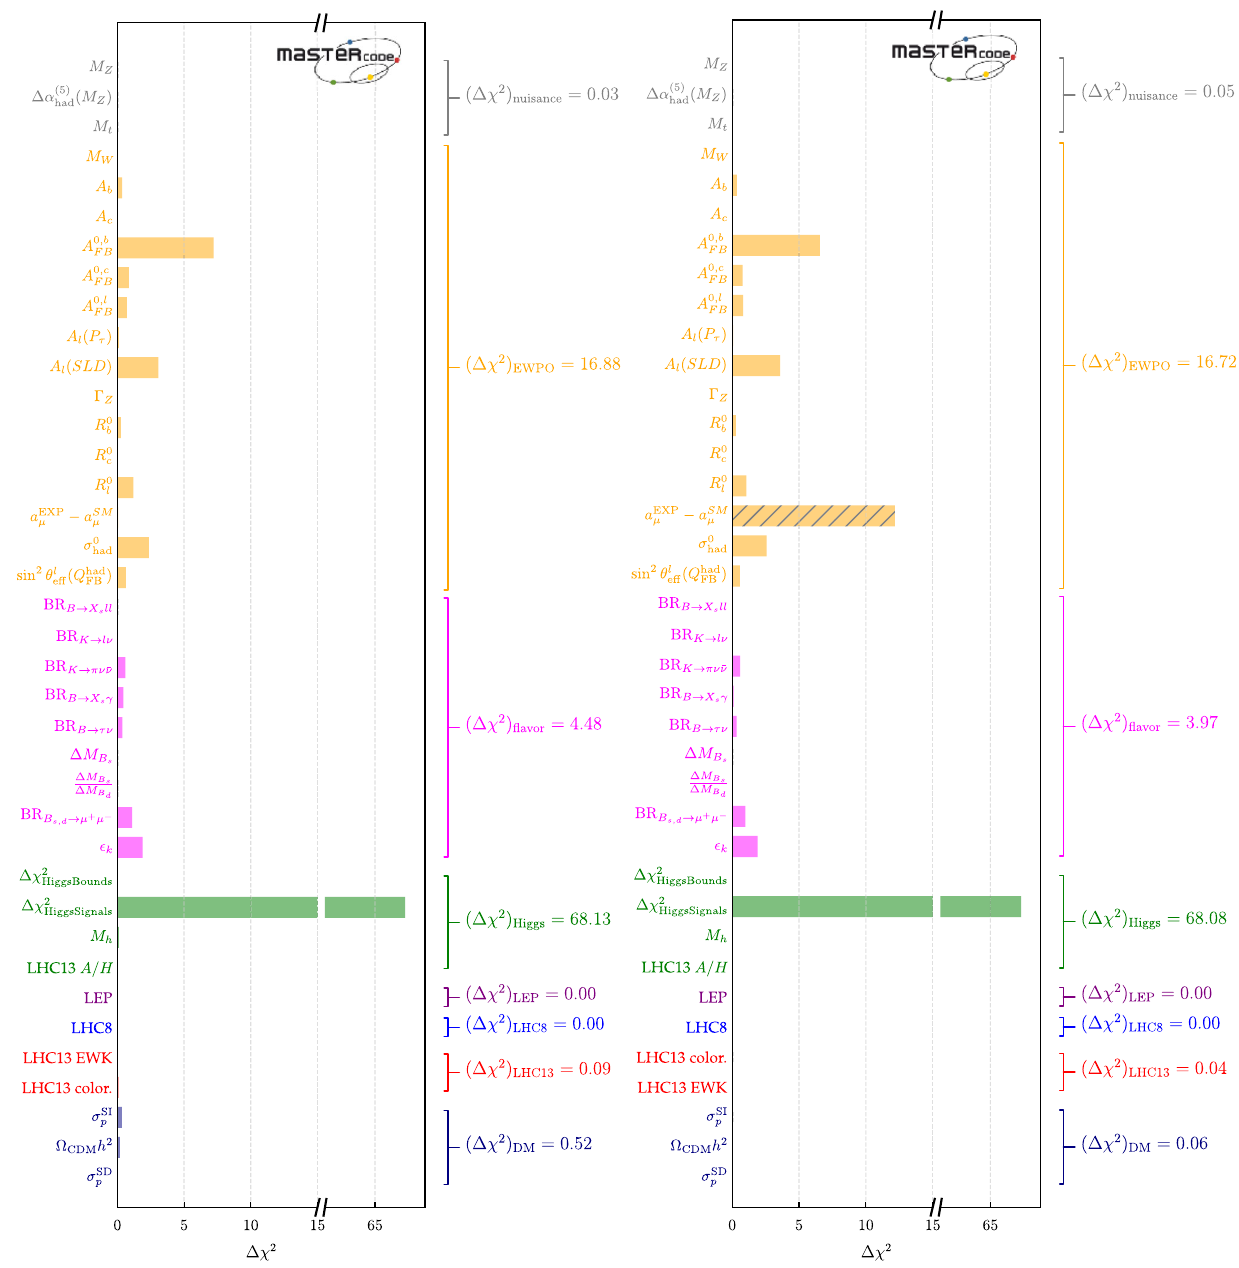
Fig. 24 The χ 2 pulls at the best-fit points in the pMSSM11 including (left) and without the ( g − 2 ) μ constraint (right). In the rightmost plot, the χ 2 pull from ( g − 2 ) μ is shown (hatched orange bar), but its penalty is not included in the fit of the 68, 95 and 99.7% CL regions in the ( m ˜ χ 0